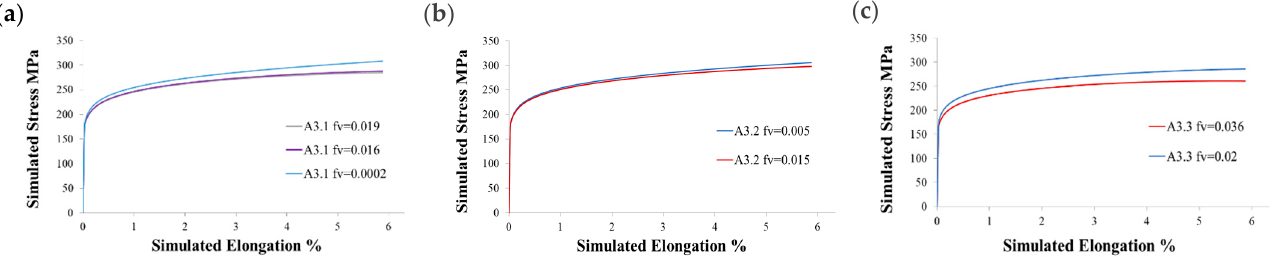
Figure 14. Gurson Model Simulation Results of A3 Sets with Different fv Porosity Levels: ( a ) A3.1; ( b ) A3.2; ( c ) A3.3.